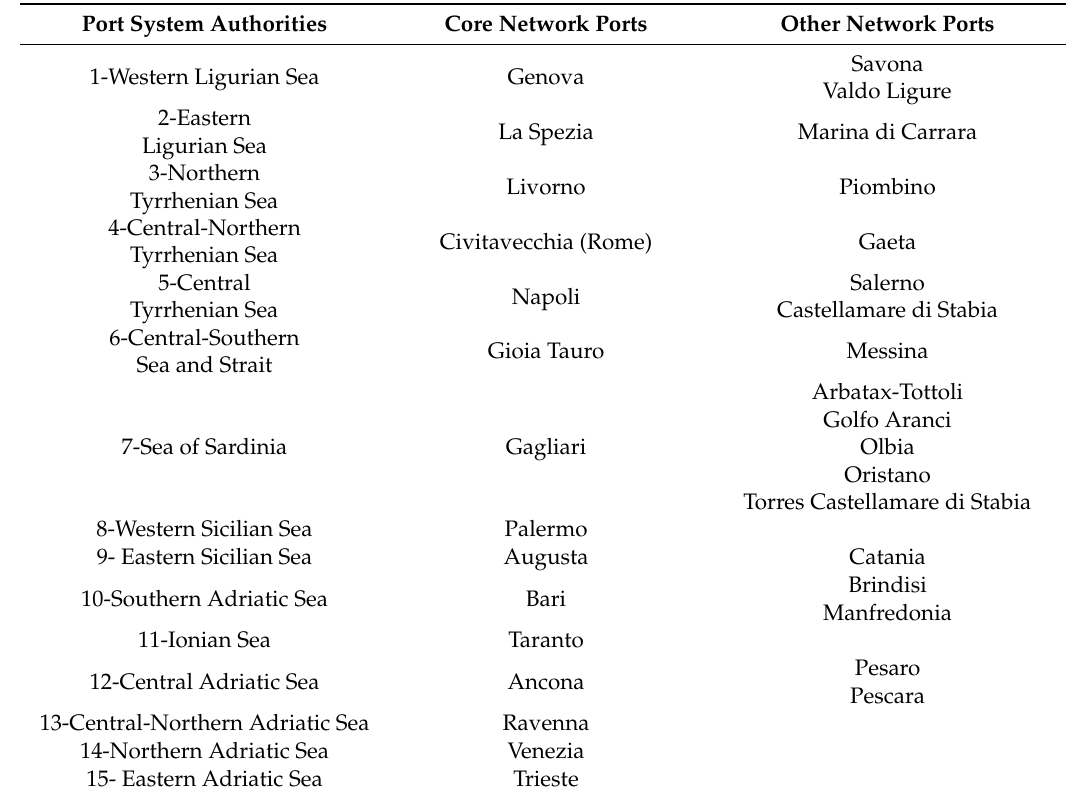
Table 9. Current Administrative Organization of the Italian Port